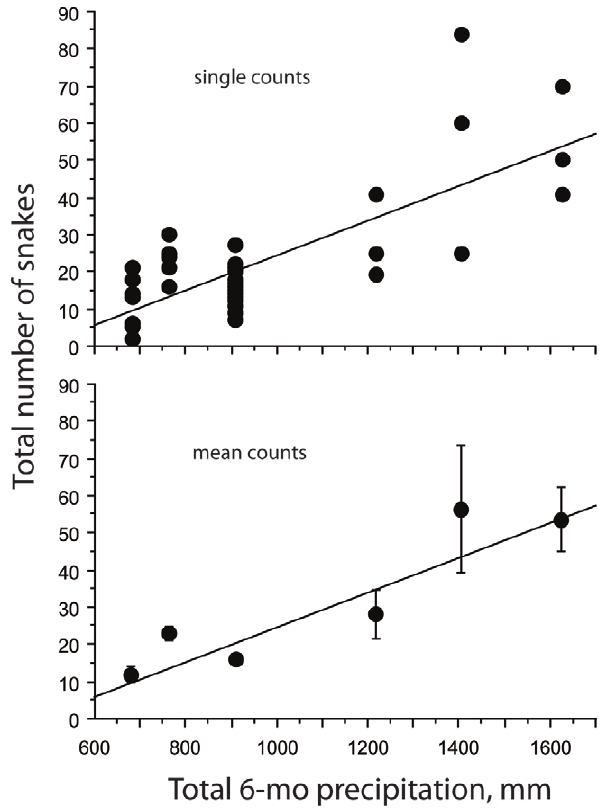
Figure 1. Relationship between total numbers of sea kraits counted on different nights during June/July and the cumula- tive precipitation during the previous six months. The upper graph illustrates data for single counts, and the lower graph plots mean 6 SE (R 2 =0.575, P , 0.0001).